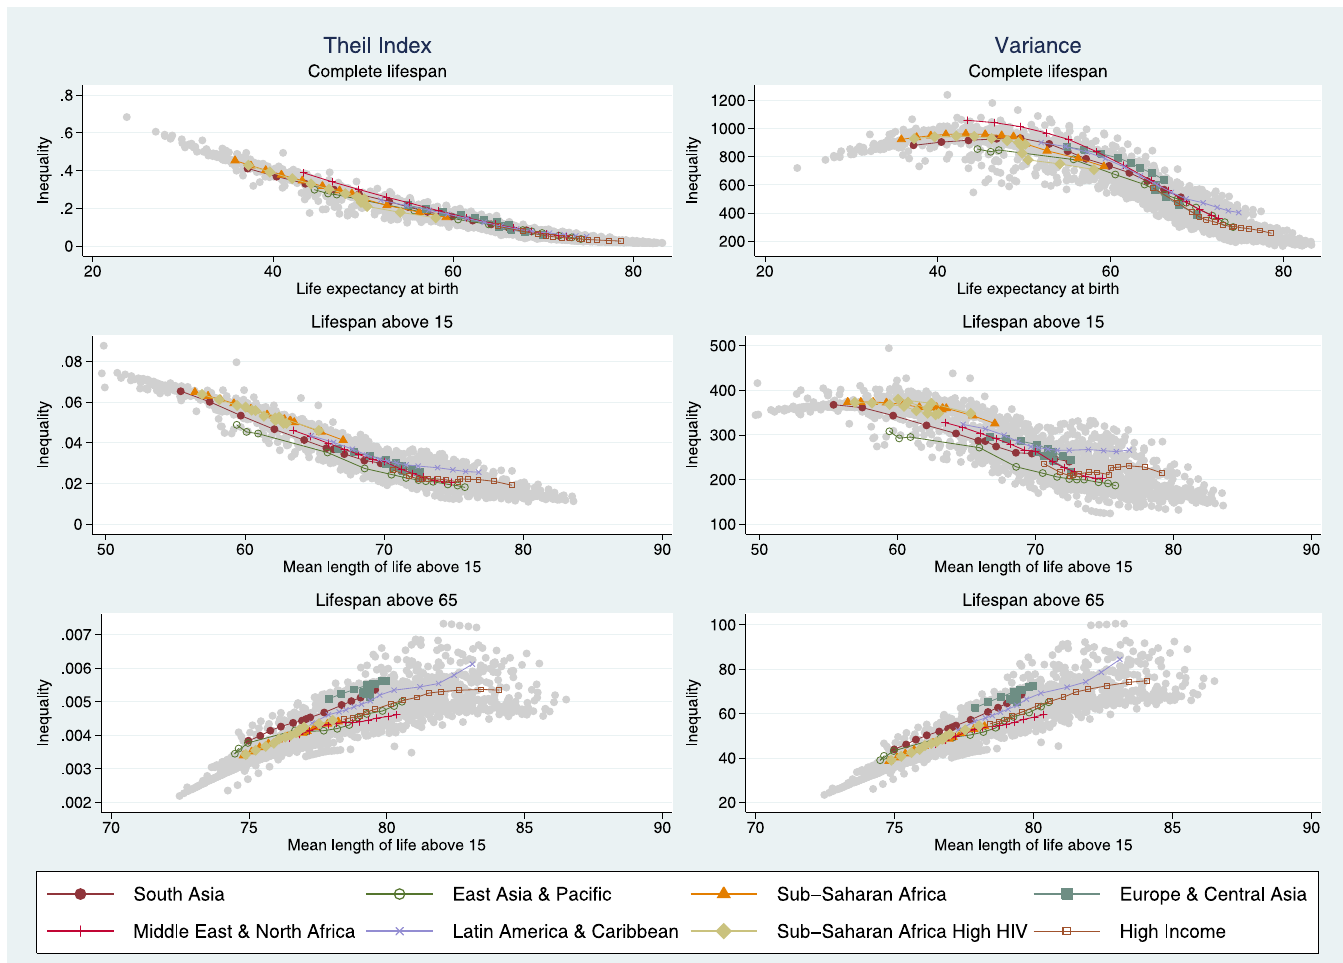
Fig 2. Scatterplots of longevity (horizontal axis) versus lifespan inequality (vertical axis) using the Theil index and the variance for overall, adult and elderly populations. Source: Authors’ calculations based on UN World Population Prospects